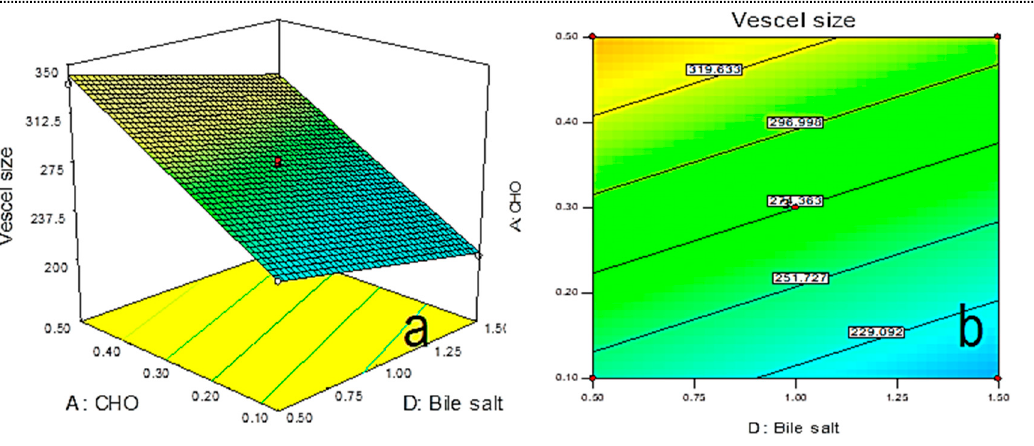
Figure 1. 3D plot showing effect ( a ) of independent variables lipid (A), cholesterol, and bile salt (D) on vesicle size. Contour plot showing effect ( b ) of independent variables lipid (A), cholesterol, and bile salt (D) on vesicle size (R 1 ).